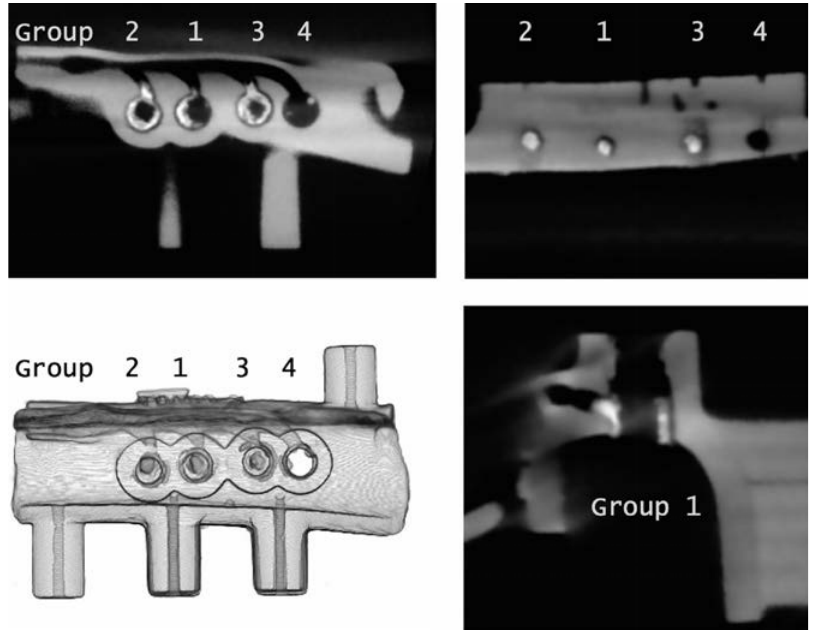
Figure 8 . Cone beam computerized tomography (CBCT) images of one of the surgical guides after the experimental phase. Condensed bone tissue partially occupies the final parts of the built-in irrigation tubes.